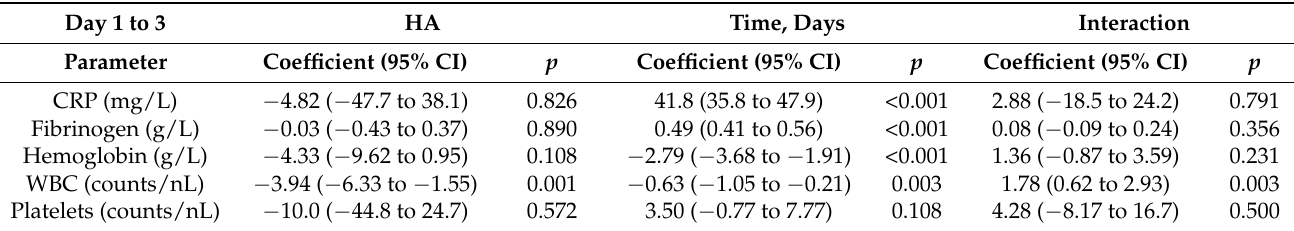
Table 5. Association of Cytosorb and biomarker development after inverse probability of treatment weights (IPTW). Day 1 to 3 HA Time, Days Interaction